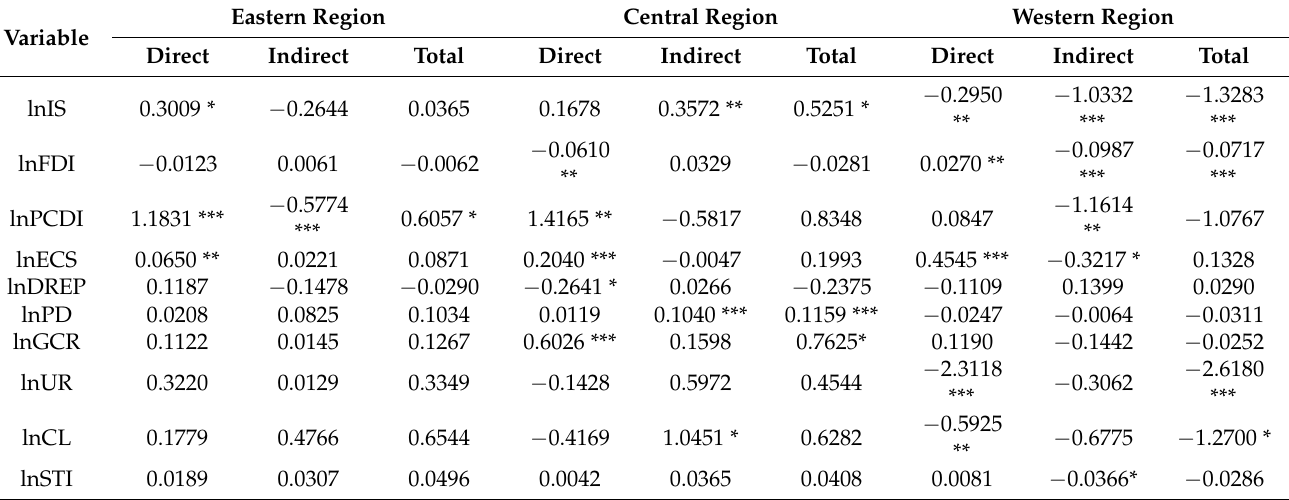
Table 12. Decomposition of sample effects of carbon emission quantity of urban production and energy consumption by